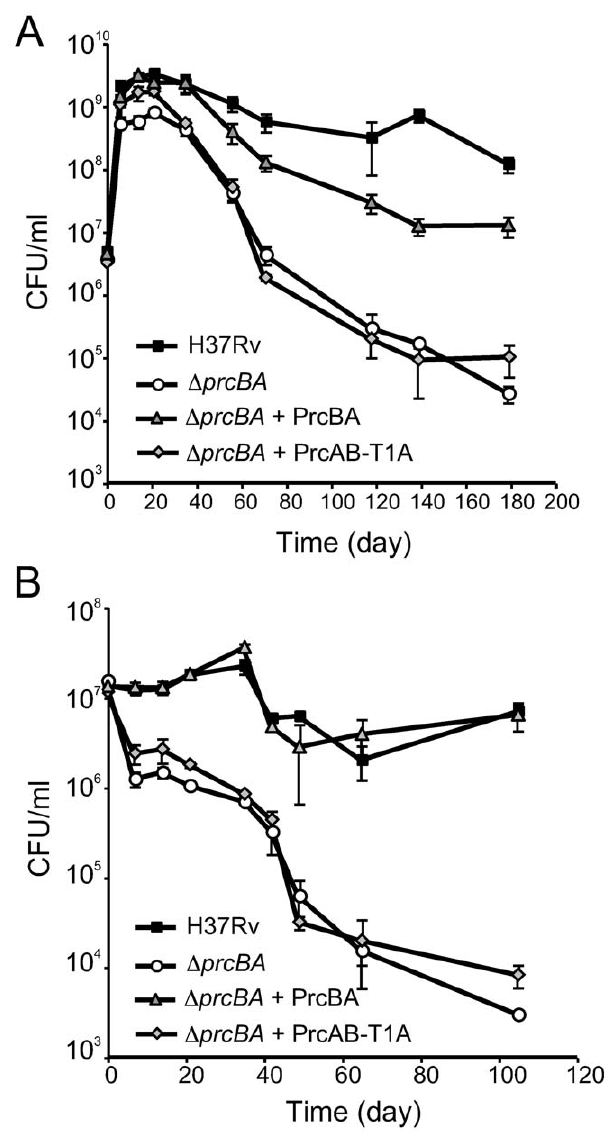
Figure 6. A proteolytically intact core proteasome is required for long-term survival in stationary phase and during starva- tion. ( A ) Growth and survival of H37Rv, D prcBA and the complemented strains in complete 7H9 growth medium. ( B ) Survival of H37Rv, D prcBA and the complemented strains in phosphate buffered saline. CFU were determined at indicated times by plating on 7H11 agar plates. Data are means 6 s.d. of triplicates and representative of three independent